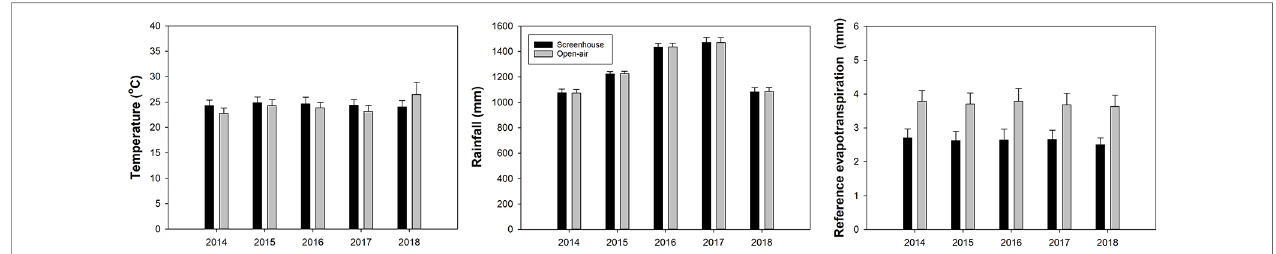
FIGURE 1 | Air temperature, rainfall and reference evapotranspiration inside the screenhouse and in the open-air plots. Average of 365 days per